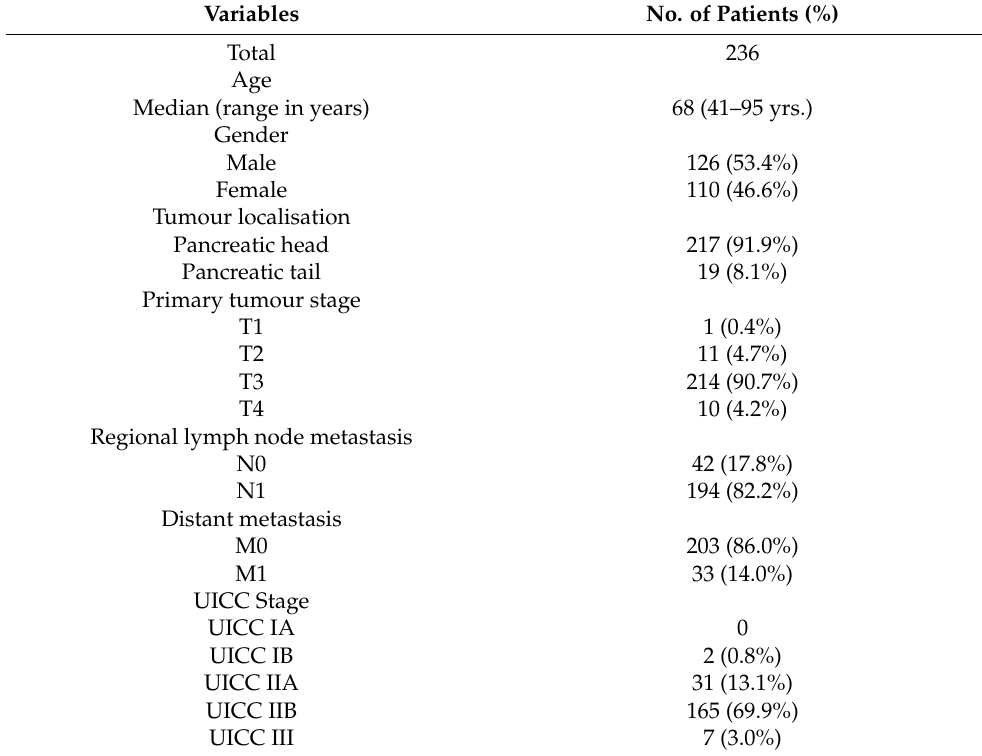
Table 1. Patient characteristics ( n = 236) 1